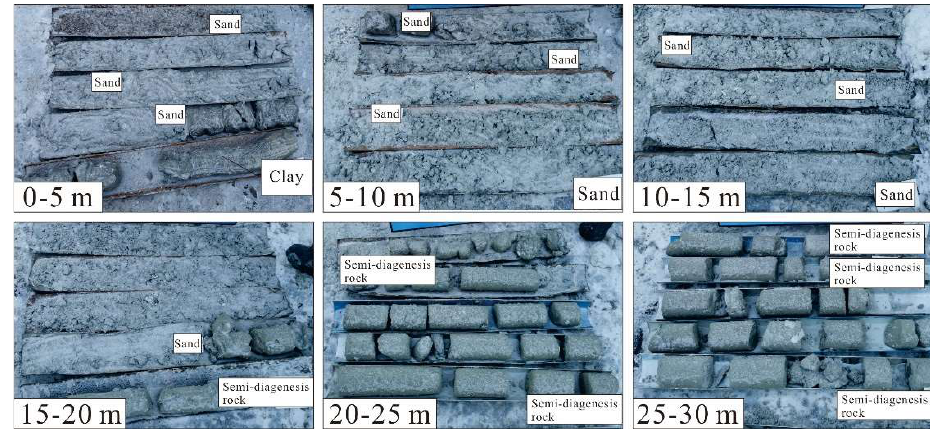
Figure 6. Photos for borehole lithology. Table 1. Mechanical properties of semi-diagenetic